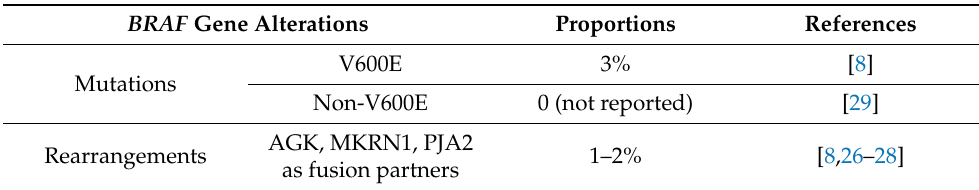
Figure 2. Schematic representation of the wild-type and the rearranged BRAF gene. All BRAF rear- rangements lead to a break leaving the serine/threonine kinase domain (or conserved region 3) and the ATP binding pocket of BRAF intact, while the N-terminal domains (conserved region 1 (CR1) and conserved region 2 (CR2)) are lost, replaced by the fusion partner. Since CR1 is known to auto- inhibit the kinase domain of the BRAF protein, its loss constitutively activates the kinase and ex- plains the oncogenic potential of the rearrangement. KIAA1549 is the most frequent BRAF fusion partner (associated with pilocytic astrocytoma), but 40 other partners have also been described (https://ccsm.uth.edu/FusionGDB/, (accessed on 20 August 2021)), such as AGK and MKRN1 (re- ported as acquired resistance mechanisms to EGFR tyrosine kinase inhibitors in EGFR -mutant lung adenocarcinoma). Abbreviations : AGK, AcylGlycerol kinase; BRS, BRAF-specific region; CR1-3, Table 2. BRAF gene alterations as acquired resistance mechanisms to osimertinib in EGFR -mutant non-small-cell lung cancer.